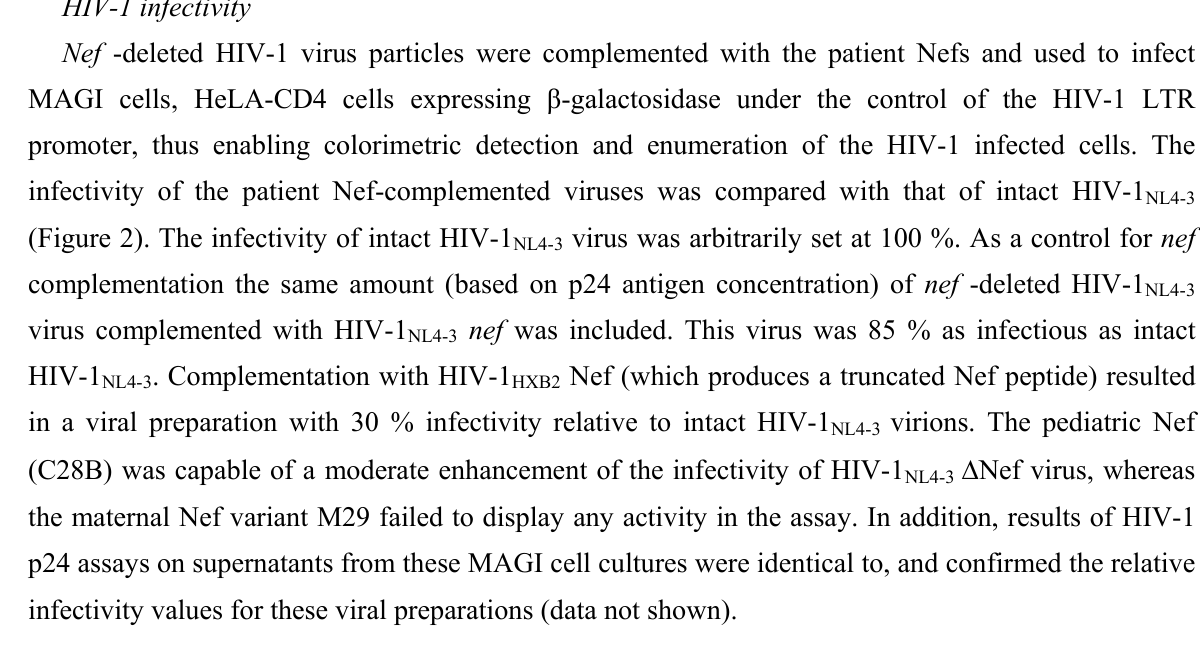
and NL4-3 Nef is indicated by an HXB2